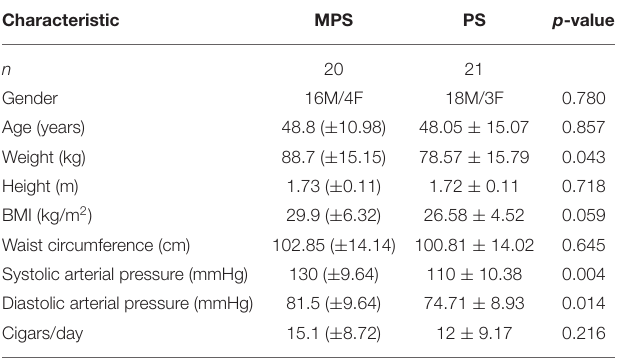
TABLE 1 | Study participants’ demographic and clinical characteristics.